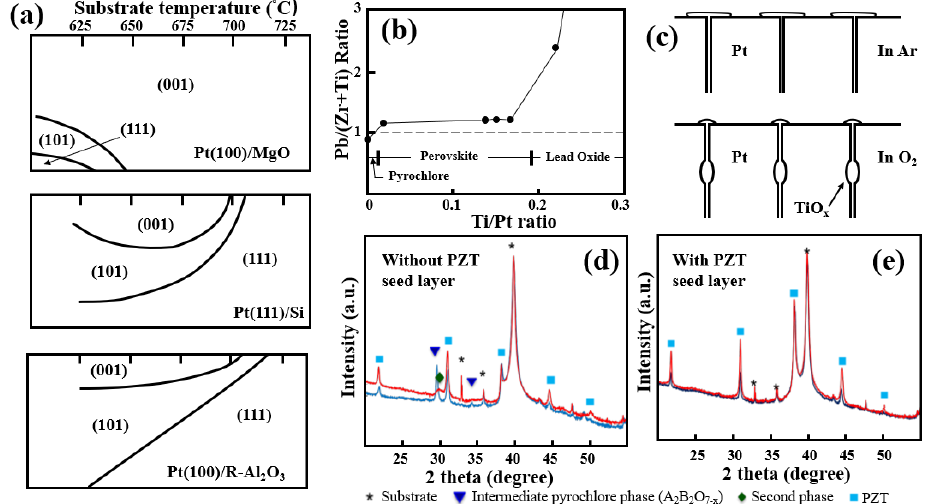
Figure 4. ( a ) Orientation changes of PZT thin films deposited on different substrate; The longitudinal axis represents the relative ratio of different orientations. Reprinted with permission from [27] Copyright 1991 The Physical Society of Japan and The Japan Society of Applied Physics; ( b ) Pb/(Zr + Ti) compositional ratio in PZT thin films as a function of Ti/Pt ratio. Reprinted with permission from [30] Copyright 1991 The Physical Society of Japan and The Japan Society of Applied Physics; ( c ) models for diffusion of Ti through Pt grain boundaries in Ar (upper) and O 2 (lower) atmosphere. Reprinted with permission from [31] Copyright 1998 The Physical Society of Japan and The Japan Society of Applied Physics; XRD patterns of as-deposited and post-annealed PZT thin films ( d ) without and ( e ) with PZT seed layer. Reprinted with permission from [11] Copyright 2018 John Wiley and Sons.